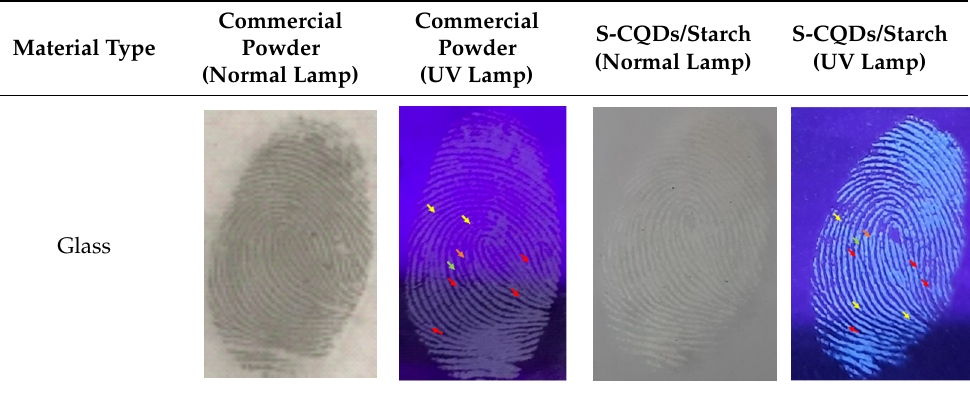
Table 3. Detection of latent fingerprints on a glass surface using S-CQDs/starch vs. commercial pow- der under normal and UV lamps.